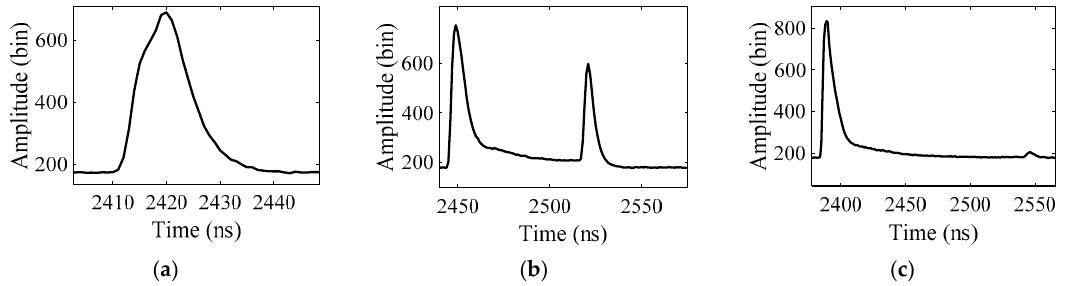
Figure 4. The received waveforms with depths of ( a ) 0.6 m, ( b ) 10.8 m and ( c ) 23.9 m.